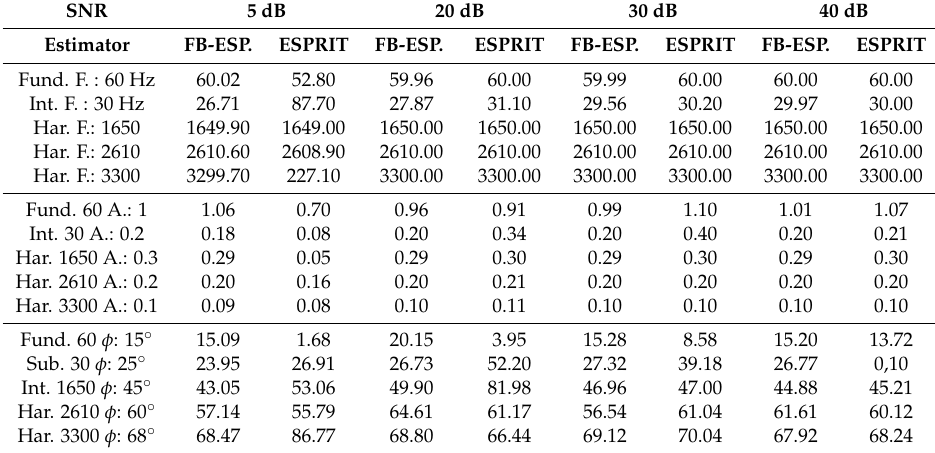
Table 2. Mean of s 1 ( t ) signal parameters estimated in 1000 runs for the FB-ESPRIT method and the